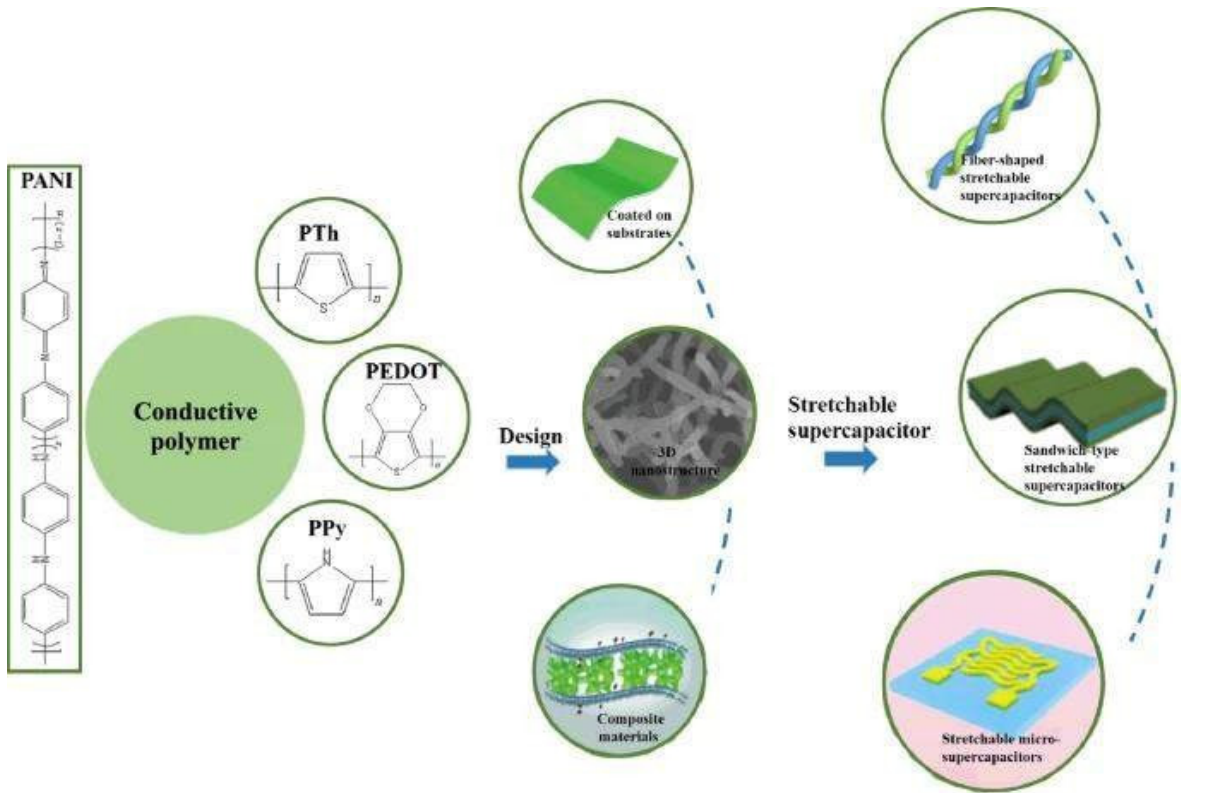
Figure 22. Stretchable supercapacitors utilizing conductive polymers. Reproduced with permission from [102].